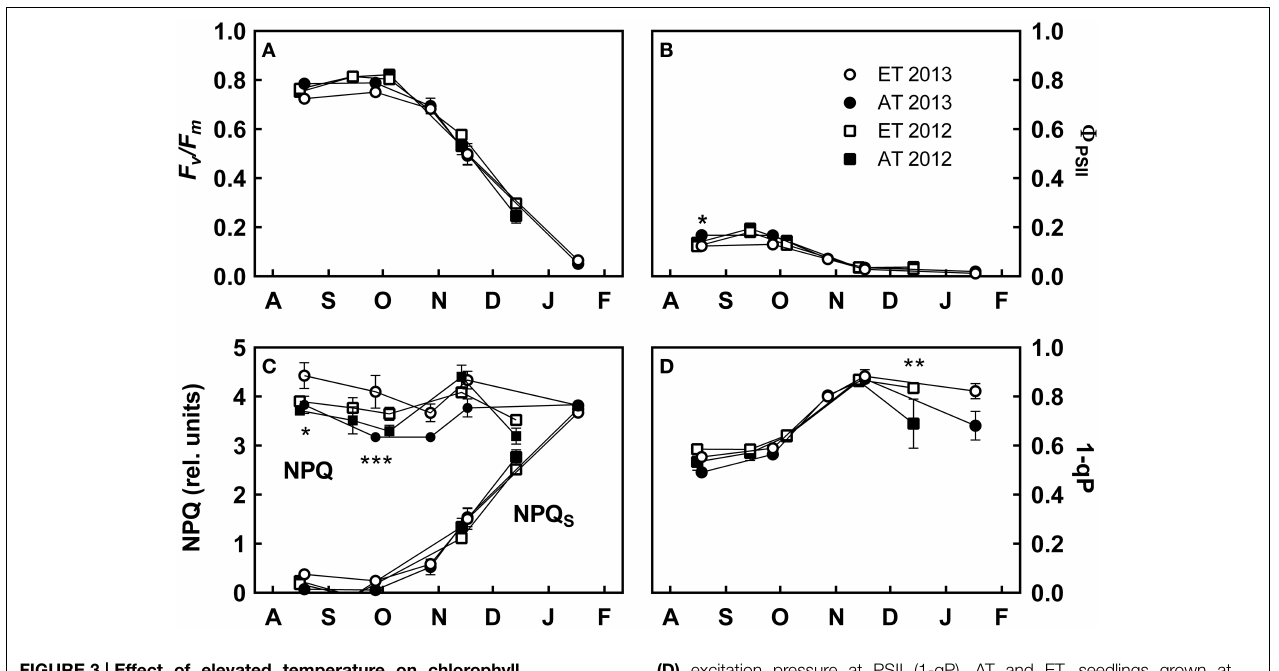
FIGURE 3 | Effect of elevated temperature on chlorophyll fluorescence in field-grown white pine seedlings during autumn. (A) Maximum quantum yield of PSII ( F v /F m ); (B) effective quantum yield of PSII ( 8 PSII ); (C) rate constant of total nonphotochemical quenching (NPQ) and sustained nonphotochemical quenching (NPQ S );